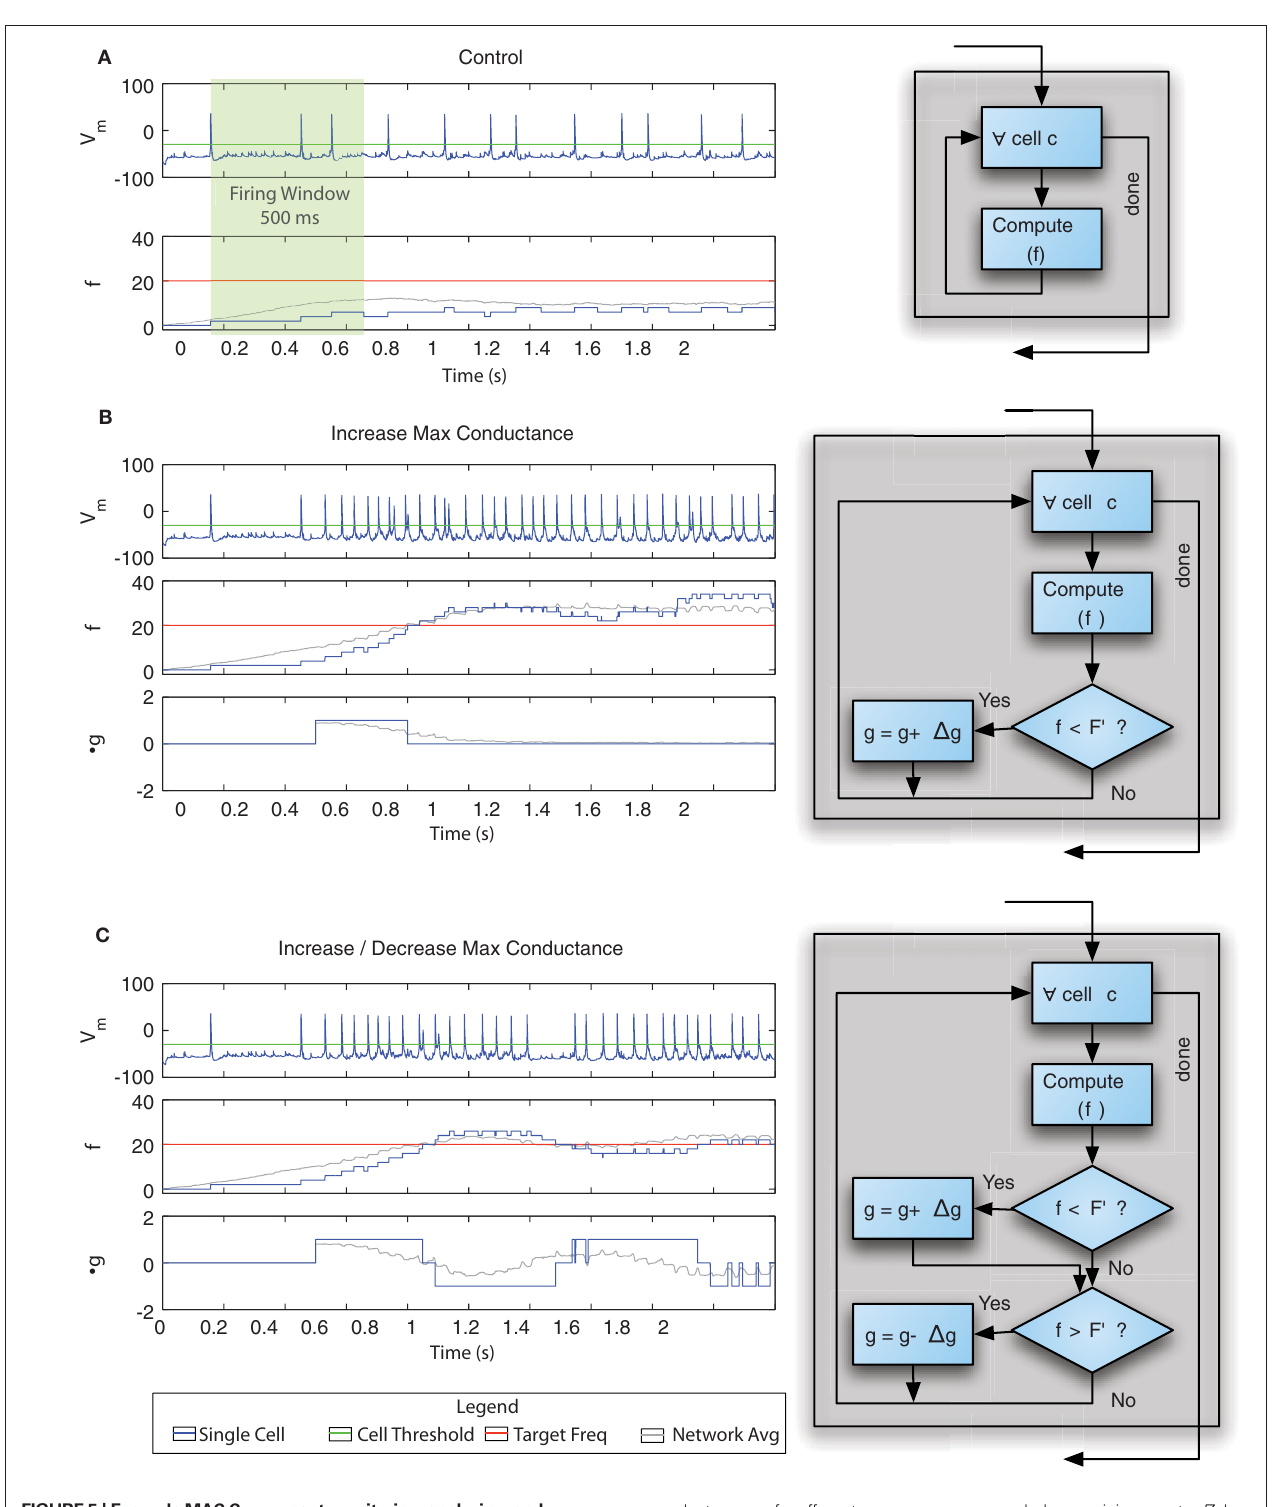
conductance, g , for afferent synapses on neurons below a minimum rate, F ′ , by an amount Δ g ; the fi rst and second graphs correspond with those of A and the third graph shows the Δ g for synapses for the selected cell as well as the mean Δ g for all cells in the network. (C) Revised MAC Component still monitoring for minimum fi ring rate but also monitoring for maximum fi ring rate, scaling back maximum conductance as needed; all three graphs correspond to those of